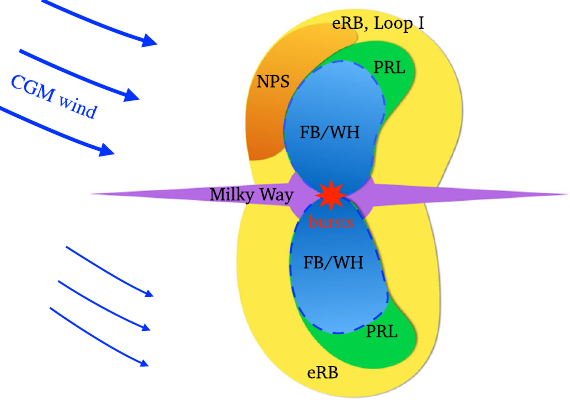
Fig. 1 | Schematic ofthe circumgalactic medium (CGM)wind model. Theyellow areas represent the radio Loop I in the northern halo and the eROSITA bubbles (eRBs), and the orange region marks the North Polar Spur (NPS) as the brightest partofLoopIandtheNortherneRB.Thegreenareas(includingtheblueinside)are 2.3GHz polarized radio lobes (PRLs).The blue areasmark the WMAP haze (WH)in 23 – 41GHz 52 and Fermi bubbles